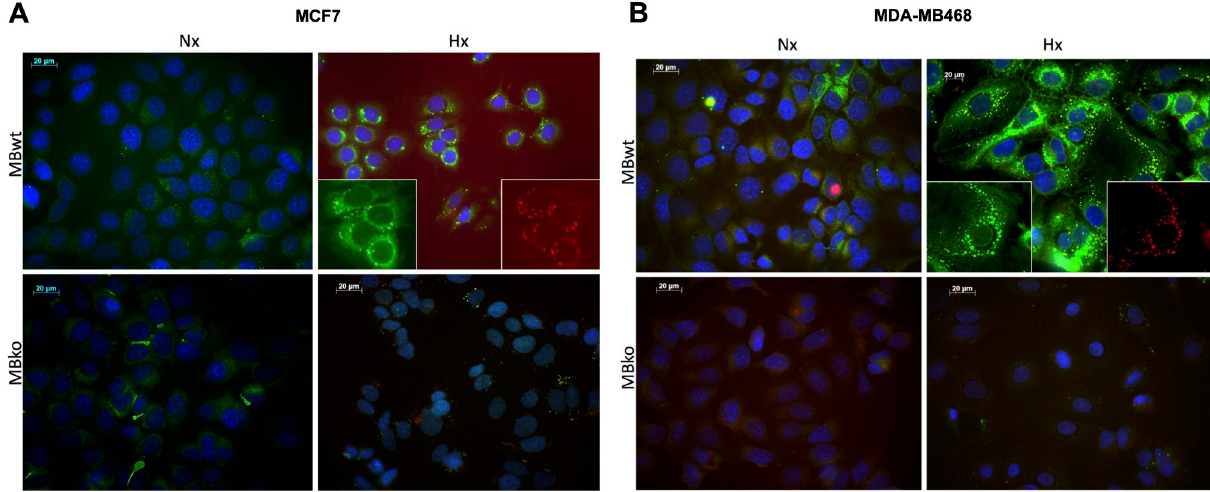
Fig 5. Lipid droplet homeostasis and MB. MB regulates lipid droplet homeostasis in an O 2 -dependent fashion. MCF7 ( A ) and MDA-MB468 ( B ) cells were incubated with BODIPY-FL C16 (green) for 30 min before exposure for 72 hrs to normoxia (Nx, oxygenated MB) or severe hypoxia (Hx, 0.2% O 2 , deoxygenated MB). Cells were then fixed and co-stained with Nile red for lipid droplets and DAPI (blue) for nuclei. The figures shown are representative of 3 independent incubations. Scale bar: 20 μ m. Magnification: 63x. Small inserts represent selected areas in higher magnification.